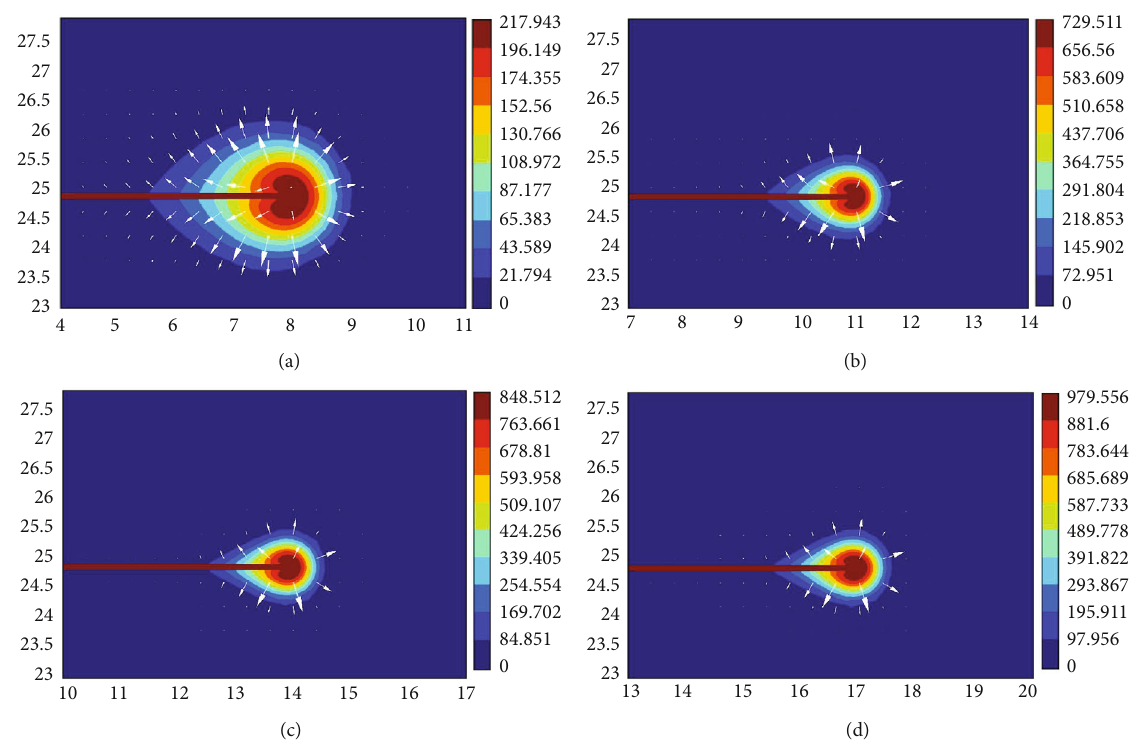
Figure 12: Distribution of gas pressure under di ff erent depths of boreholes when t = 3600 s (local): (a) the hole depth of 5m; (b) the hole depth of 8m; (c) the hole depth of 11m; (d) the hole depth of 13 m.